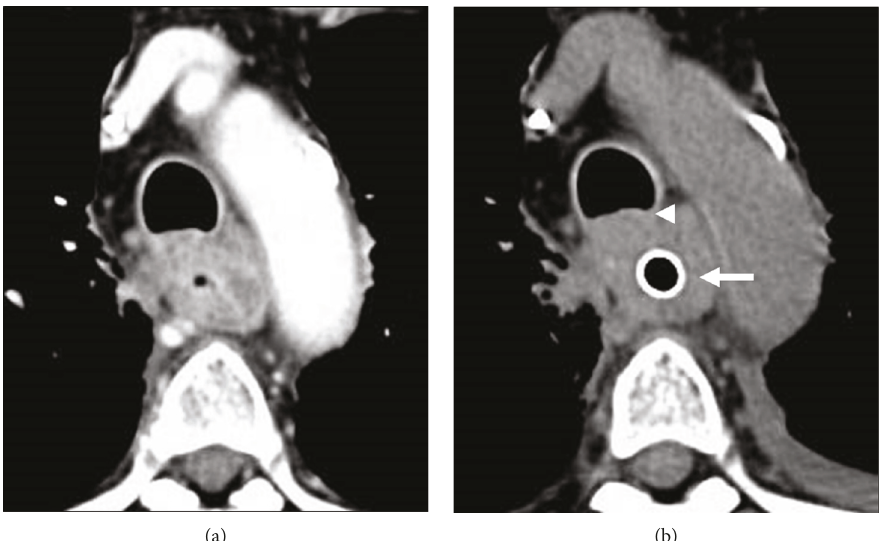
Figure 3: (a) CT fi ndings before stent placement. Two months after chemoradiotherapy, the tumor located in the middle thoracic esophagus had invaded the trachea. (b) CT fi ndings after Niti-S ultrathin stent placement (arrow). The membranous portion of the trachea did not transform